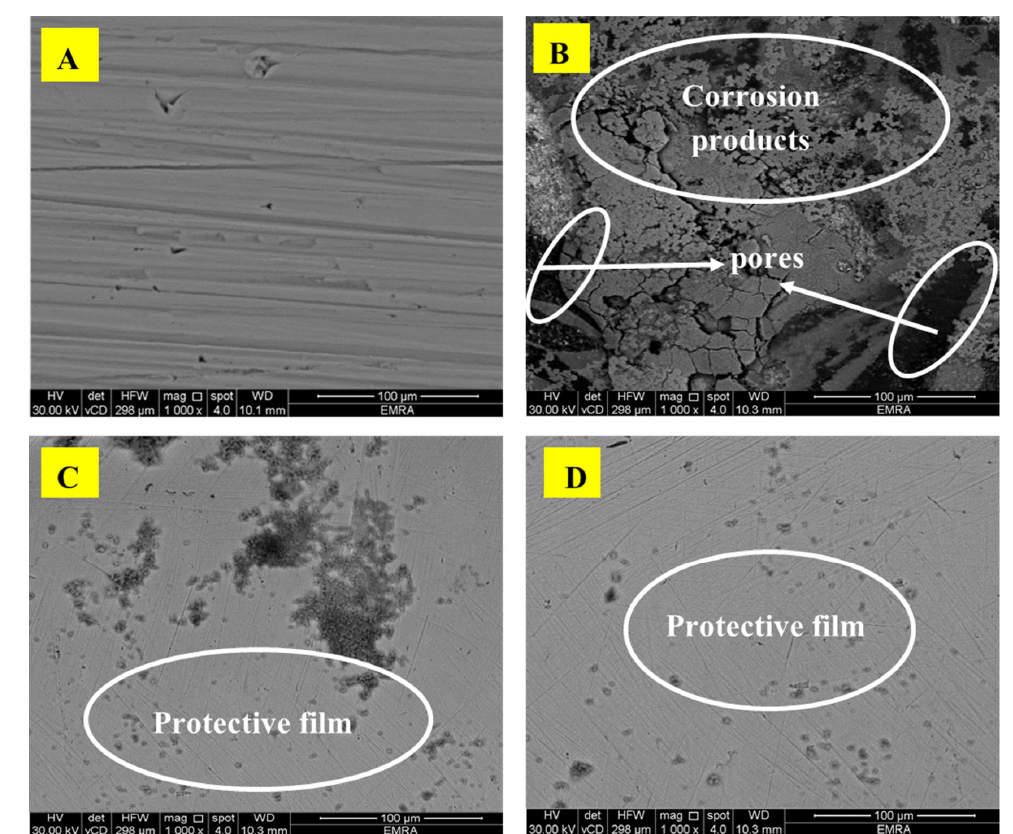
Figure 12. SEM pictures of the SS316 alloy surface; ( A ) before dipping; ( B ) after dipping in 2.0 M HCl solution-free inhibitor; ( C ) after dipping in 2.0 M HCl + 200 mg/L CEL; ( D ) after dipping in 2.0 M HCl + 200 mg/L NCC. Exposure time = 48 h, at 323 K.